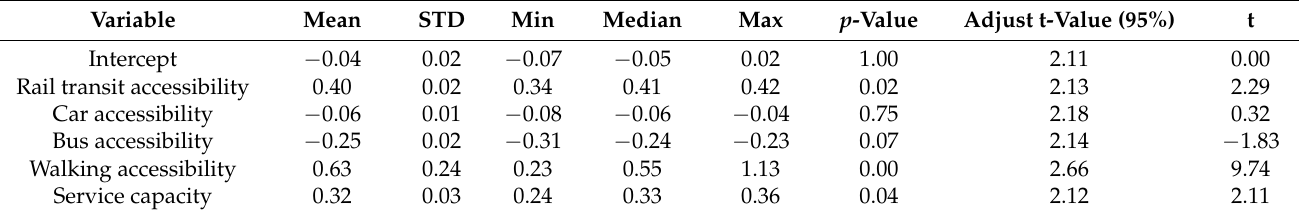
Table 4. Summary statistics for MGWR parameter estimates.